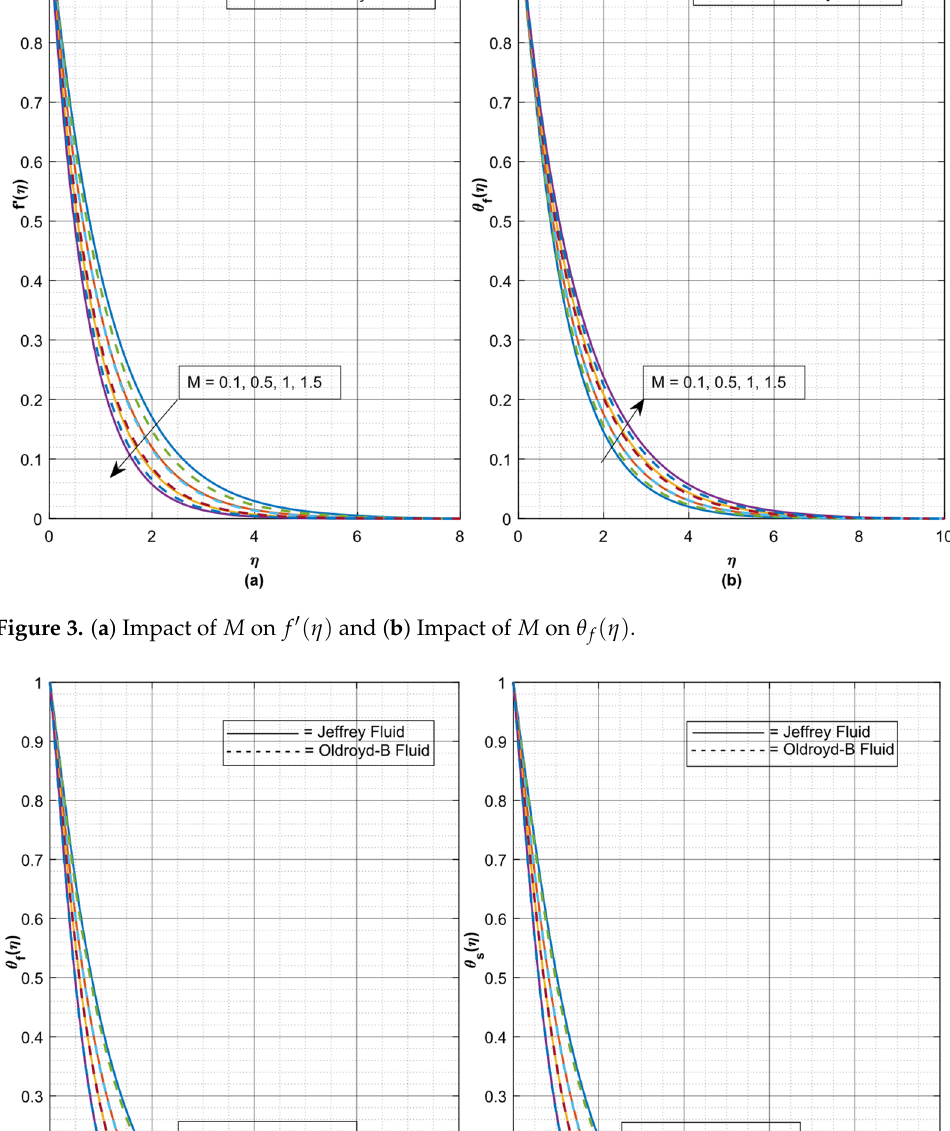
( ) θ η γ on and (b) Impact of f